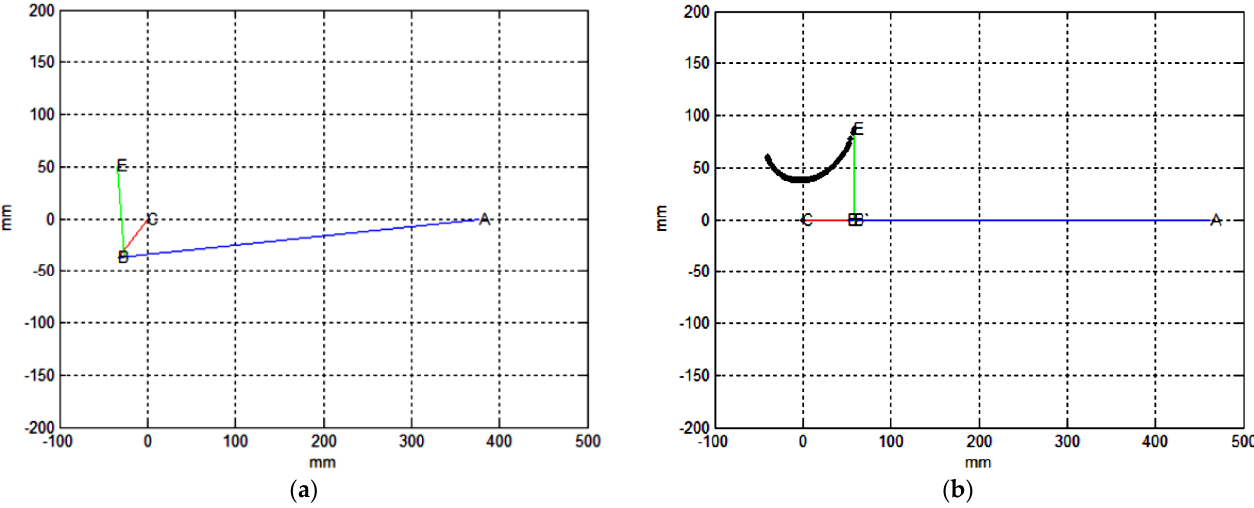
Figure 8. A design solution for the mechanical design: ( a ) A scheme of a design solution for the A–AFiM, and ( b ) simulation of the Flexion and extension trajectory